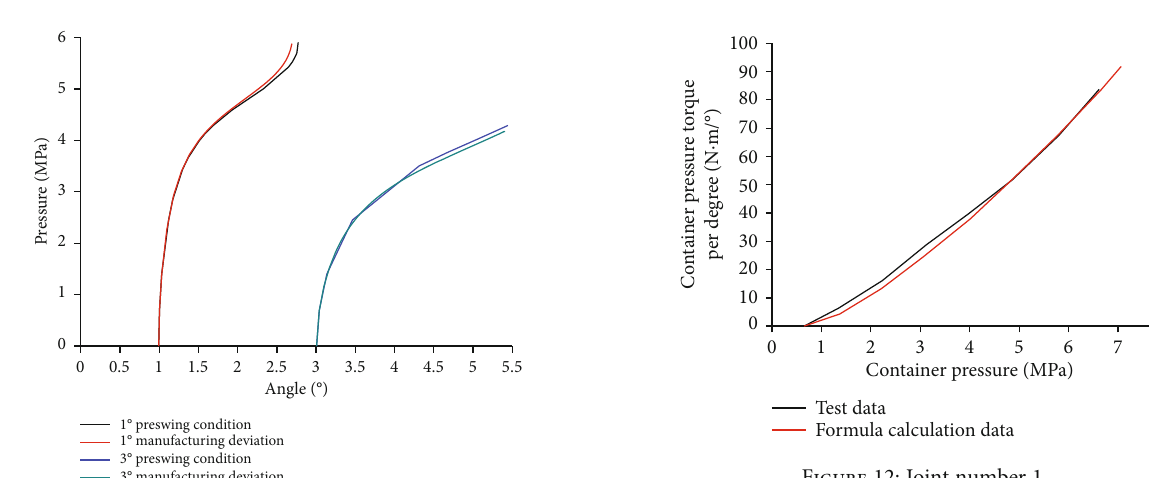
Figure 10: Initial state before the fl exible joint is swung (there are two conditions: (a) the fl exible joint rotates by 1 degree or 3 degrees of swing angle; (b) the 1- or 3-degree swing angle produced by the manufacturing error).